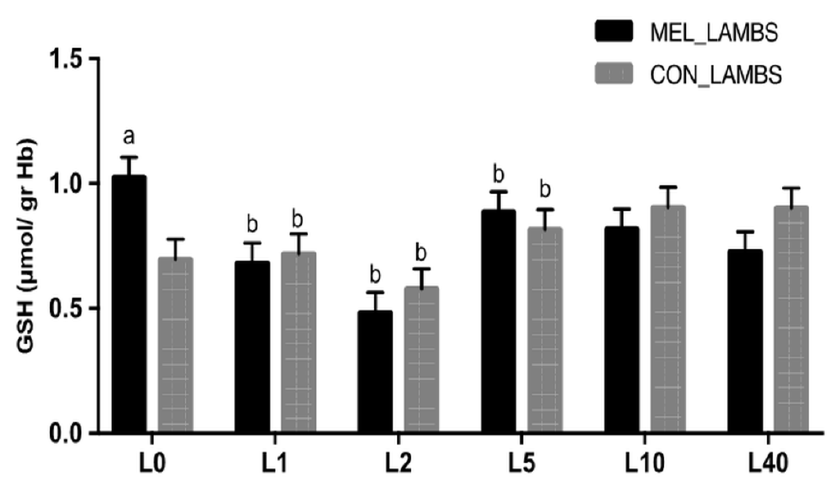
Figure 3. Least squares means ± SEM of glutathione levels (μmol/gr Hb) in lambs’ erythrocyte lysate, in control group (CON) and in melatonin group (MEL), at birth (L0) and on days 1 (L1), 2 (L2), 5 (L5), 10 (L10) and 40 (L40) of their life, p < 0.05, a: among the two groups, b: within time.